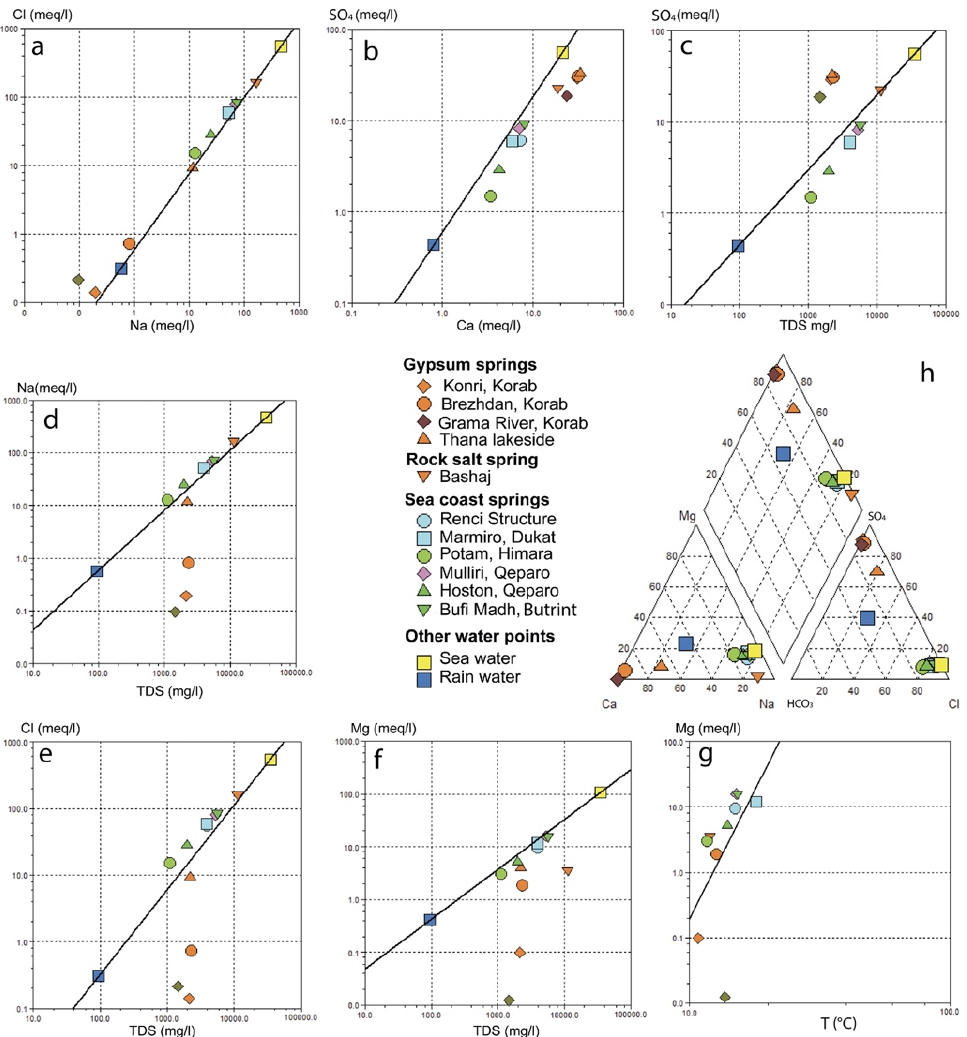
Figure 11. Plots showing the correlations between: ( a ) Cl and Na; ( b ) SO 4 and Ca; ( c ) SO 4 and TDSs; ( d ) Na and TDSs; ( e ) Cl and TDSs; ( f ) Mg and TDSs; ( g ) Mg and T; ( h ) a Piper diagram.